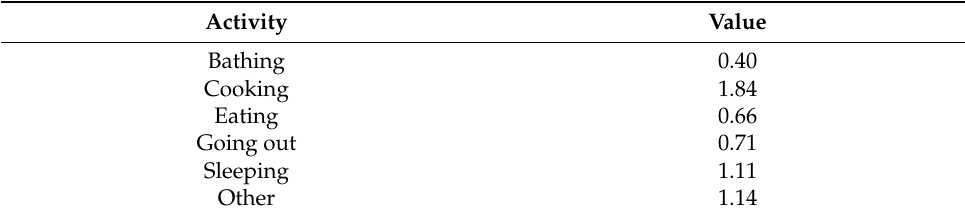
Table 4. Activity indicator for Subject ID1/woman.